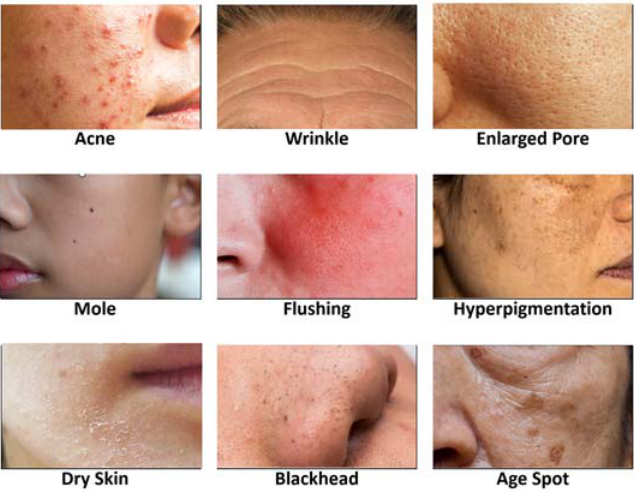
Figure 1. Different types of facial skin problems.